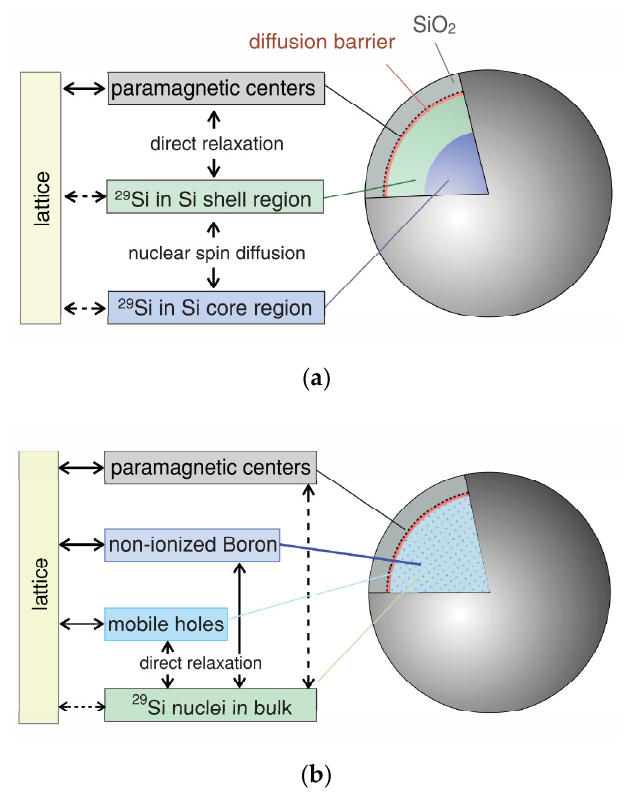
Figure 5. ( a ) Model showing the spin reservoirs and relaxation pathways in undoped silicon particles. Nuclei in the core region of the particle relax by transferring their magnetization to the nuclei in the shell region, nearer to the surface, by spin diffusion. The nuclei near the surface can relax quickly due to strong dipolar coupling to paramagnetic defects at the Si/SiO 2 interface. ( b ) Rate model showing dominant nuclear relaxation pathways of direct relaxation on mobile holes and short diffusion to non-ionized B (i.e., bound holes) throughout the bulk of the boron-doped particle. Long-distance spin diffusion to surface impurities is relatively slow and direct coupling of the nuclei to the lattice is weak. (Reprinted figures with permission from Reference [20] © (2011) by the American Physical Society).